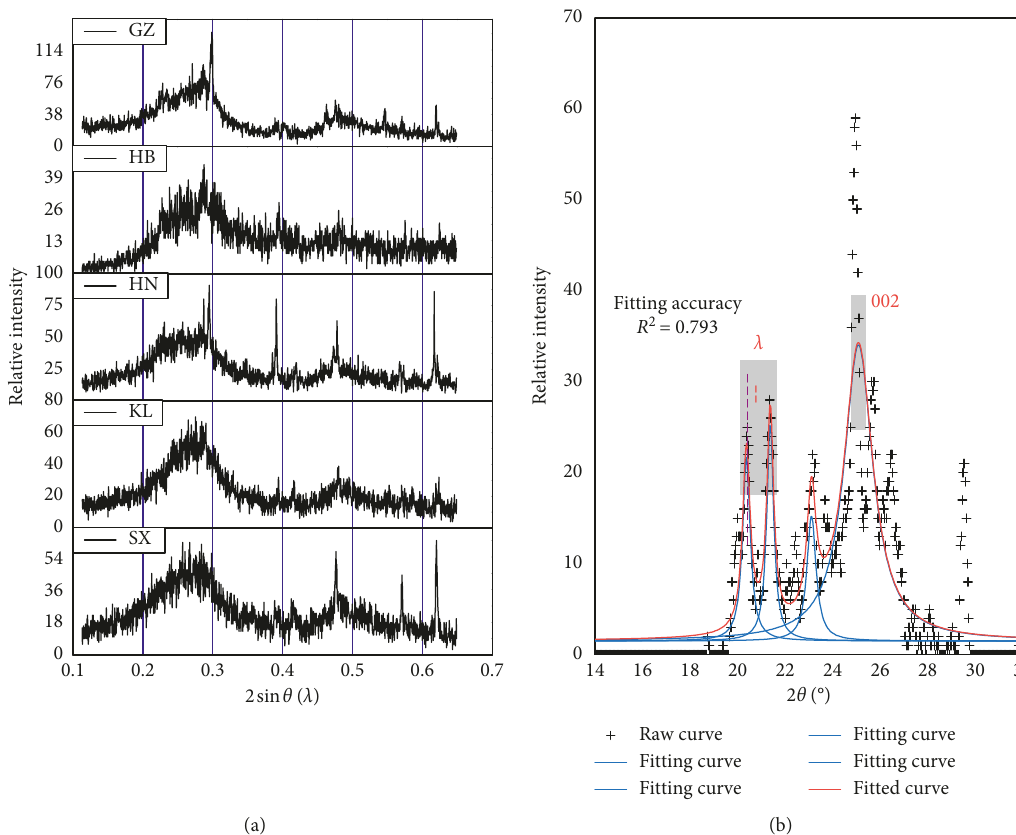
Figure 6: XRD pattern of five coal samples before pyrolysis (a) and the curve fitting result of the SX coal sample before pyrolysis as a function of Gaussian function